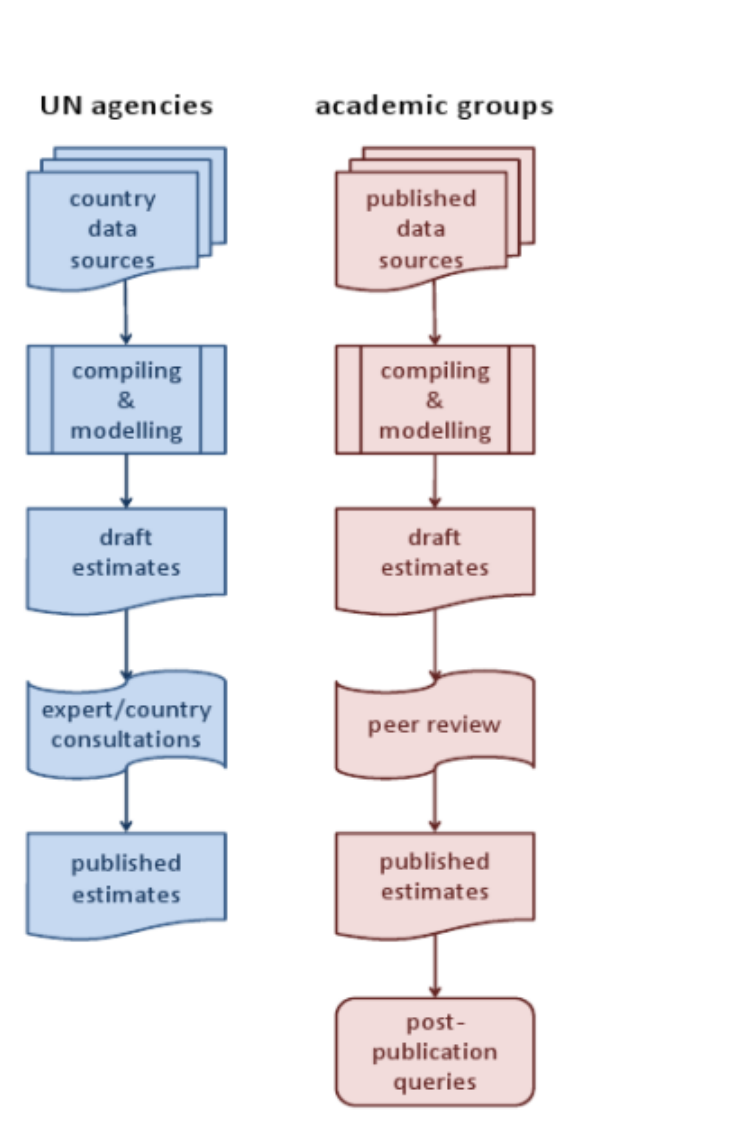
Figure 1. Approaches to global estimates by UN agencies and academic groups.